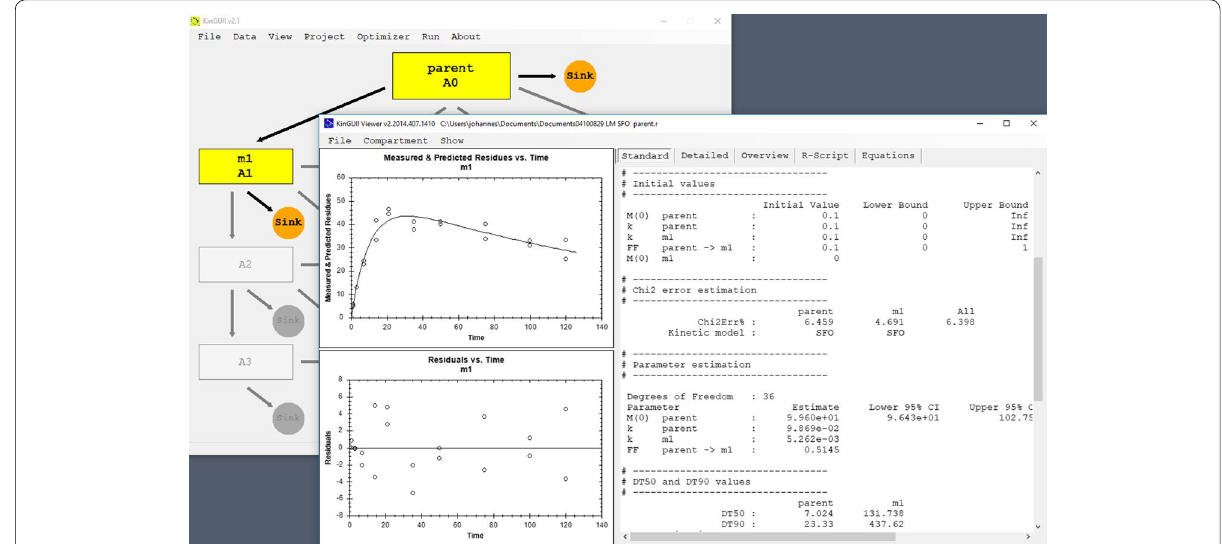
Fig. 2 Screenshot of KinGUII v2.1 The model definition is shown on the left and the result viewer with a graph and some numerical results on the